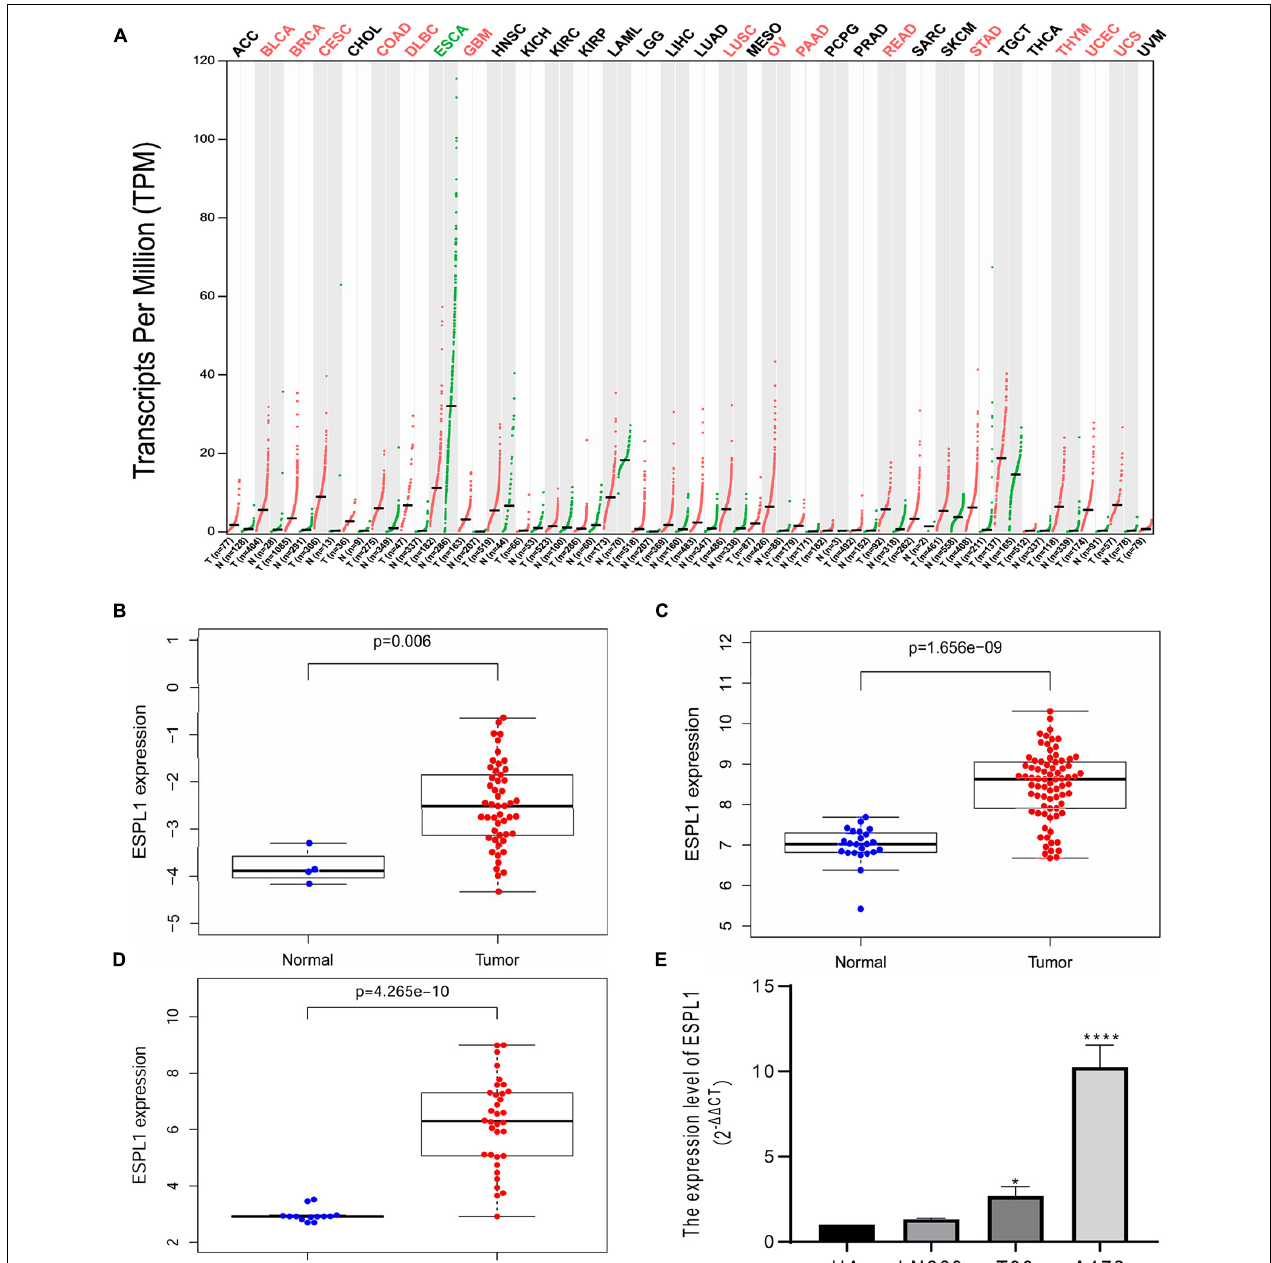
FIGURE 1 | Extra spindle pole bodies-like 1 expression in gliomas. (A) The expression of ESPL1 in a variety of malignant tumors. Red indicates that ESPL1 is higher than the corresponding normal control group, while green indicates that ESPL1 is highly expressed in the tumor. (B) ESPL1 expression in 50 gliomas and 4 normal brain tissues in GSE2223. The expression of ESPL1 in gliomas was significantly increased. (C) In the GSE4290 data, the expression of ESPL1 in 77 gliomas and 23 normal brain tissues was compared, and the expression of ESPL1 in gliomas increased. (D) Comparing 34 kinds of glioma tissue specimens with 13 normal brain tissue specimens in the GSE50161 data set, the expression level of ESPL1 in glioma tissue was significantly increased. (E) RT-qPCR experiments show that the expression level of ESPL1 in glioma cell lines (LN229, T98, and A172) is higher than that in human astrocytes. * p < 0.05 and **** p <